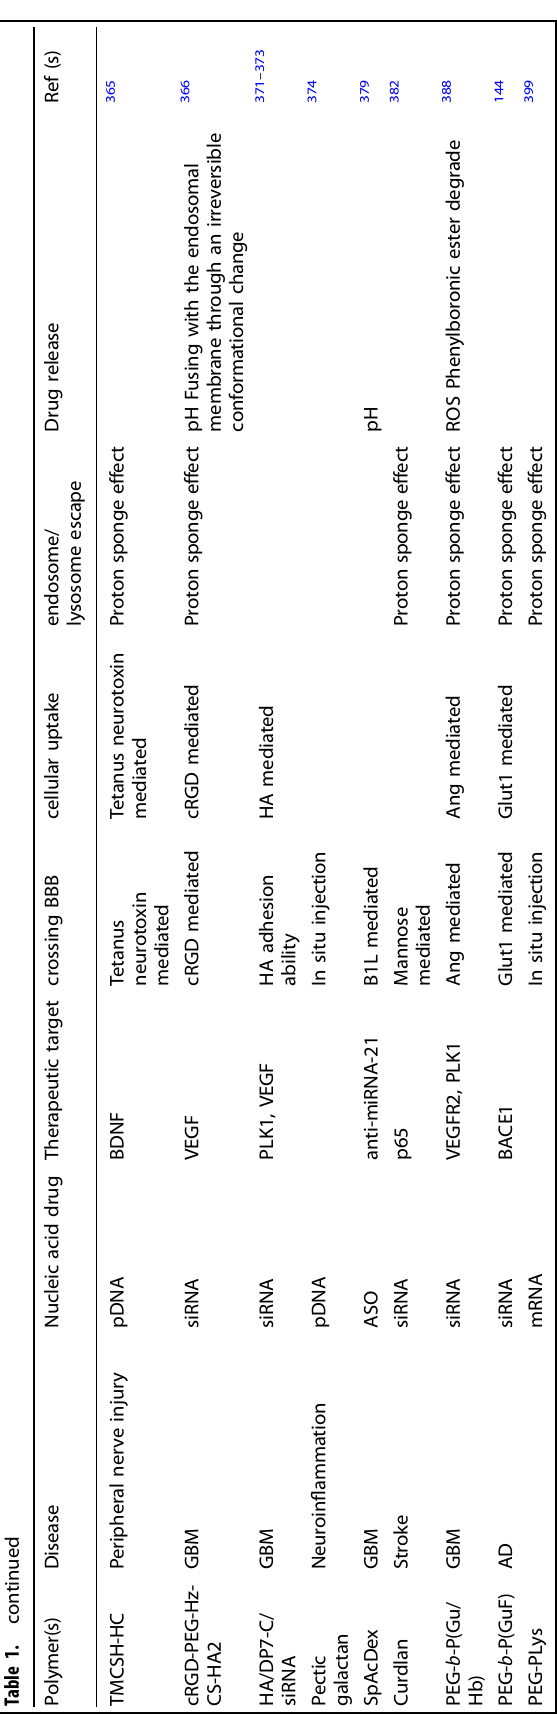
cancer progression and metastasis. 479 – 481 Therefore,